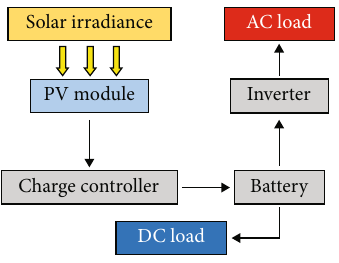
Figure 1: Solar system with energy